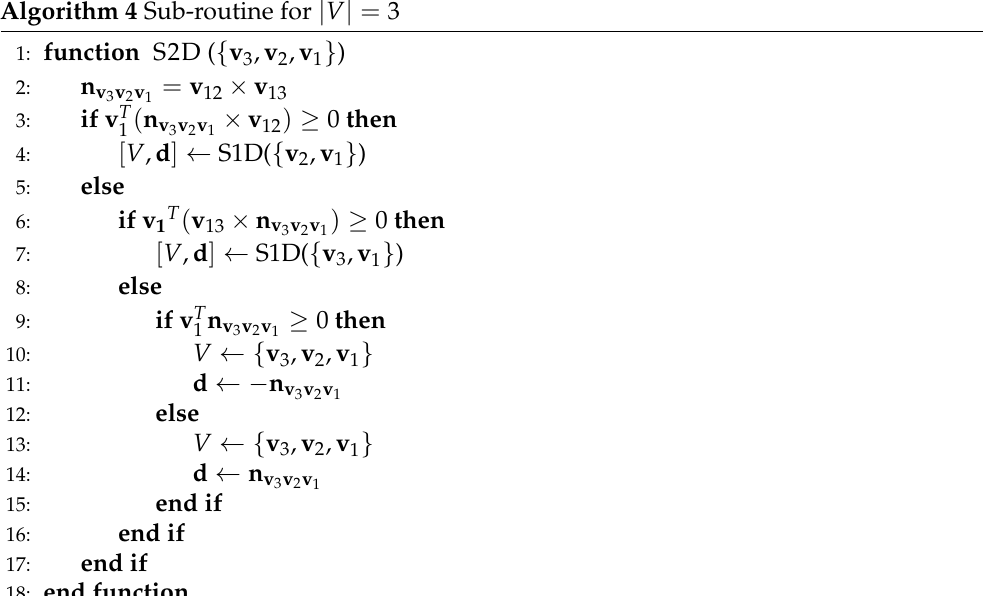
Figure 4. An m-simplex is linked to 2 m + 1 − 1 Voronoi regions associated with its vertices, edges, faces, and volume. The list of 2 m Voronoi regions that can possibly contain the origin is given in this table. It should be noted that v 1 is the latest vertex added to V . Algorithm 4 Sub-routine for | V | =